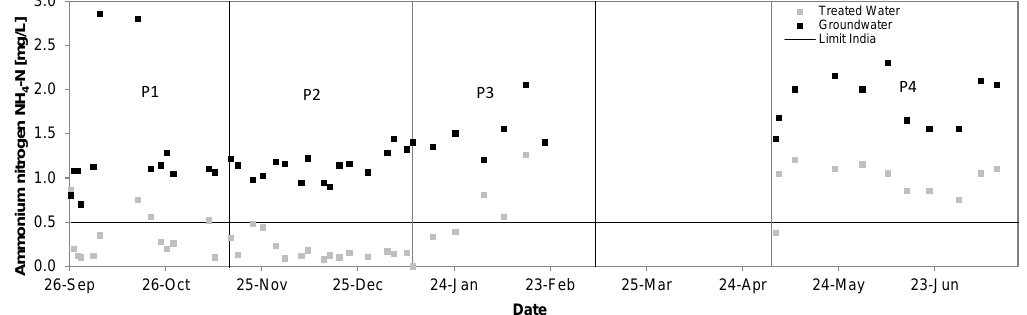
Figure 8. Ammonium nitrogen concentrations in groundwater and treated water during test phase, Kalyani pilot system, September 2016–July 2017.